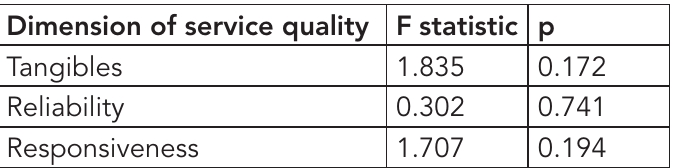
Table 3: ANOVA – Expectations and industry